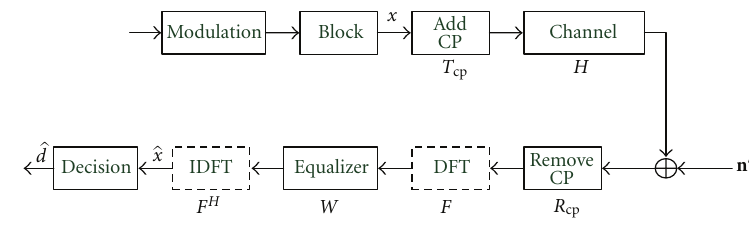
Figure 1: Block diagram of SCBT